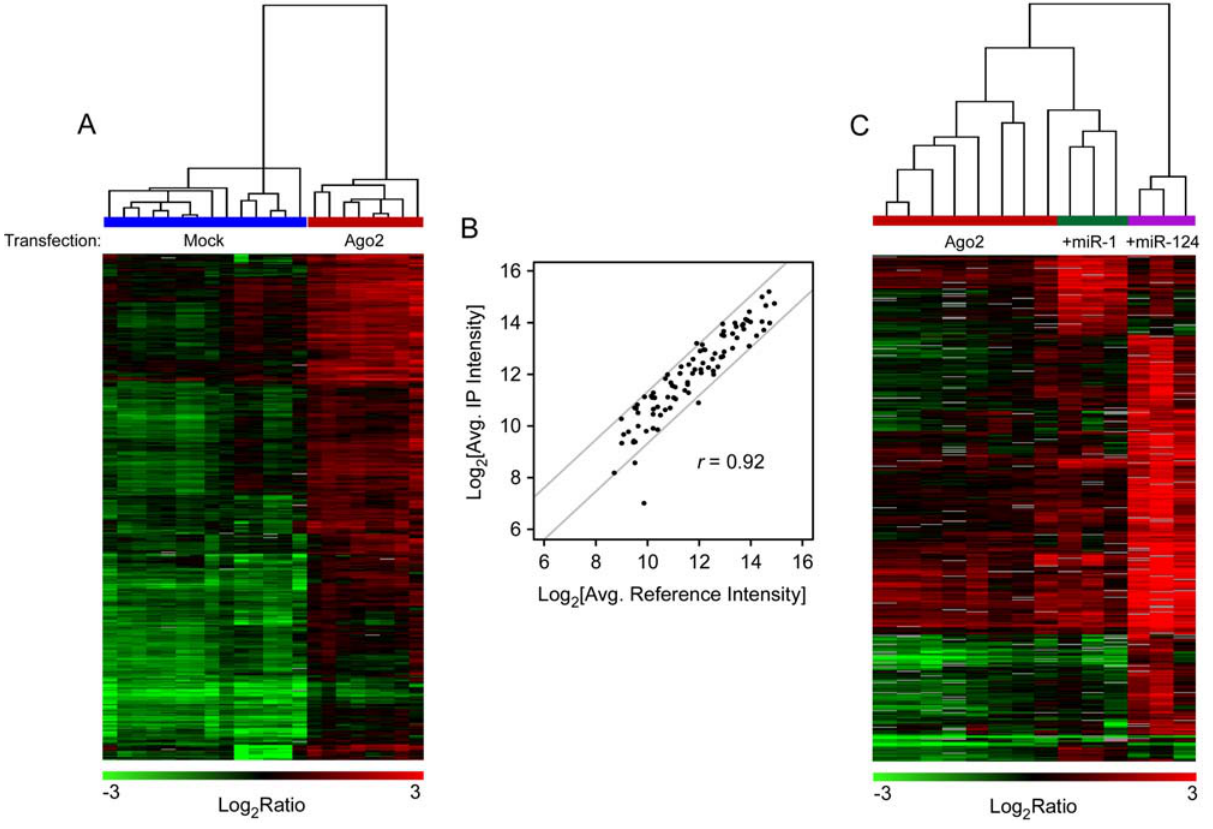
Figure 3. Comparison of mRNA and miRNA specifically associated with Ago2 in the absence or presence of miR-1 or miR-124. (A) Supervised hierarchical cluster of putative Ago2 targets that are enriched over mock (local FDR 1%) from FLAG purifications of FLAG-Ago2 transfected cells (red) and mock transfected cells (blue). Rows correspond to 1,215 gene elements (representing , 1,083 genes) and columns represent individual experimental samples. There is a high correlation between replicate experiments: r ave =0.80 for Ago2 replicates, 0.73 for mock replicates, and 2 0.070 for all experiments. (B) Scatter plot of the normalized log 2 microarray signal intensities of 90 miRNAs from whole cell lysate (x-axis) graphed against the normalized log 2 microarray signal intensities of miRNAs associated with Ago2 (y-axis, r =0.92). Four replicates were performed for each experiment. The grey lines delineate the boundary for a two-fold change. (C) Supervised hierarchical clustering of putative miR-1 and miR-124 targets enriched over Ago2 alone (1% local FDR) from FLAG purifications of FLAG-Ago2 transfected cells alone (red) and FLAG-Ago2 transfected cells with miR-1 (green) or miR-124 (purple). Rows correspond to 667 gene features (representing , 544 genes) and columns represent individual experimental samples. r ave = 0.80 for Ago2 replicates, 0.77 for Ago2 + miR-1 replicates, 0.90 for Ago2 + miR-124 replicates, and 0.43 for all experiments.